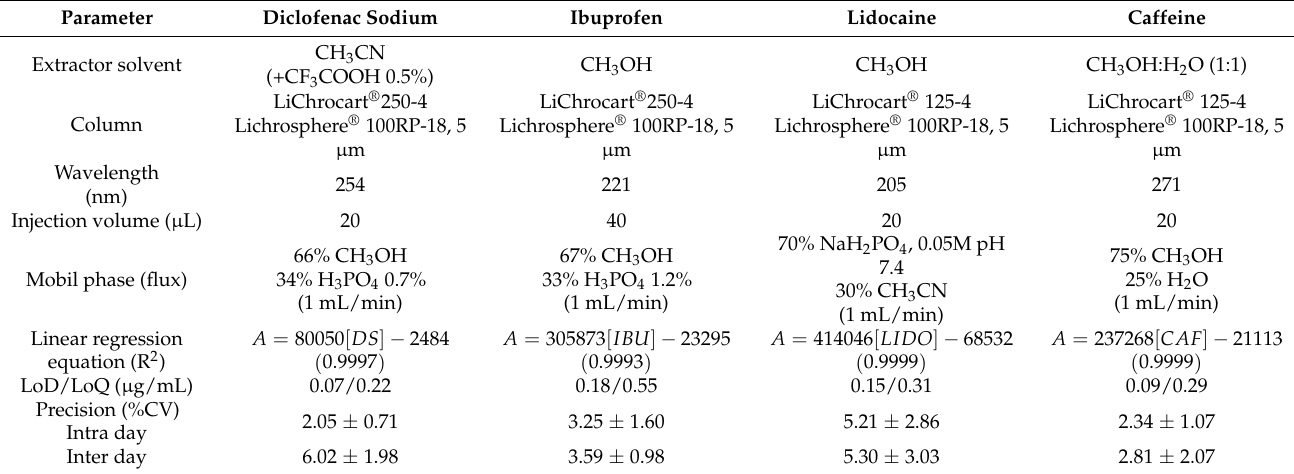
Table 1. HPLC analytical conditions and parameters for diclofenac sodium (DS), ibuprofen (IBU), lidocaine (LIDO), and caffeine